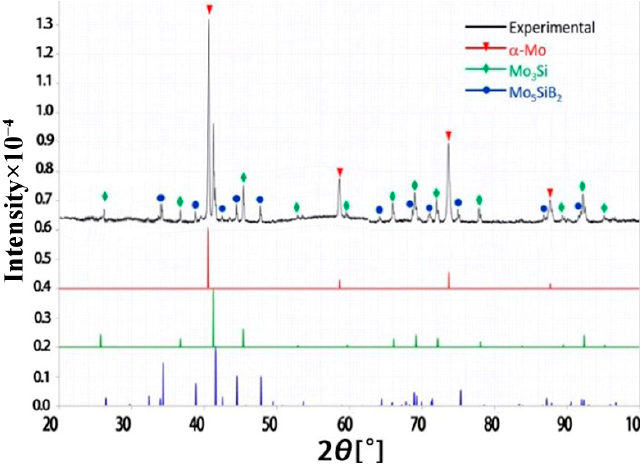
Figure 7. The XRD results of electron beam remelted Mo-12Si-8.5B alloy.